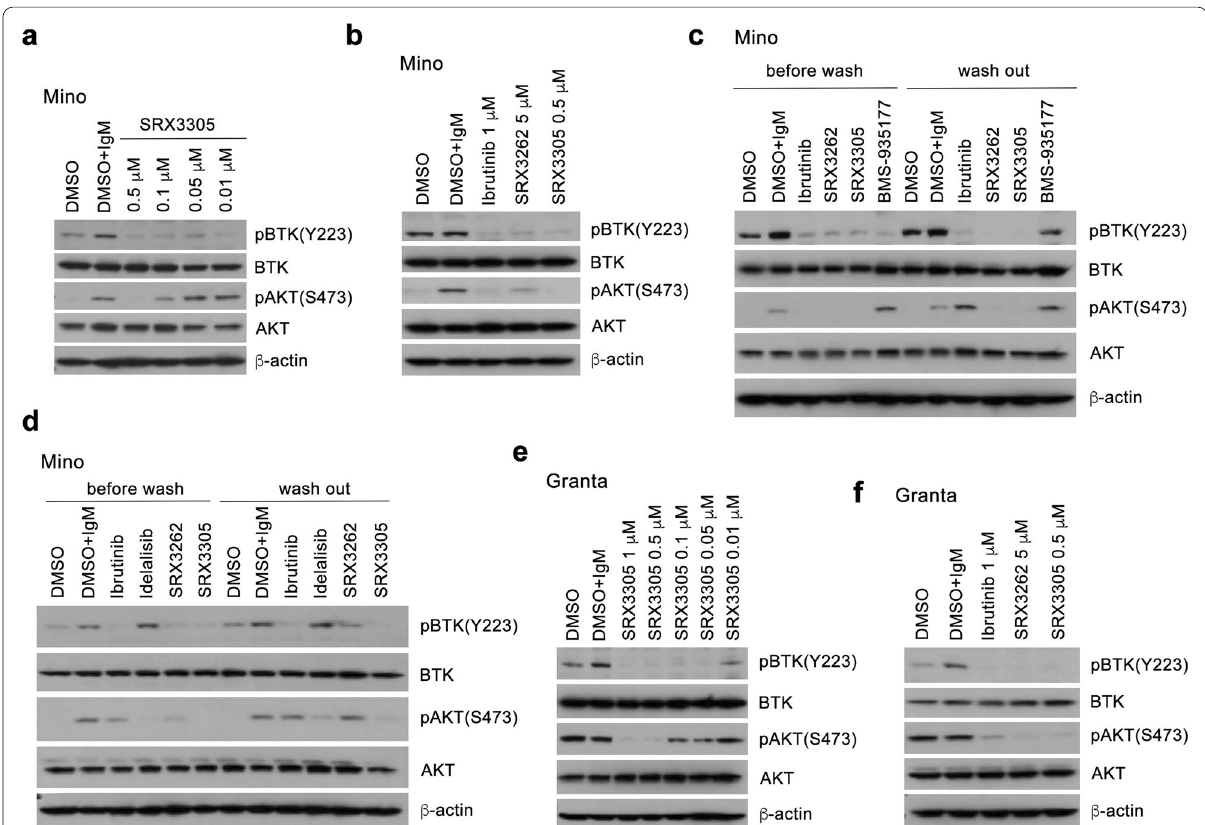
Fig. 3 SRX3305 is efficacious in MCL and Ibrutinib‑resistant MCL cells. a , b Western blot analysis of lysates from IgM‑stimulated Mino cells treated with the indicated concentrations of Ibrutinib, SRX3305 or SRX3262 for 1 h. BTK and PI3K signaling was assessed by the levels of BTK, phosphorylated at Y223 BTK [pBTK(Y223)], AKT, and phosphorylated at S473 AKT [pAKT(S473)]. c , d Western blots analysis of lysates from IgM‑stimulated Mino cells without and with washing out indicated inhibitors 24 h post treatment. e , f Western blot analysis of lysates from IgM‑stimulated Granta cells treated with increasing concentrations of SRX3305, SRX3262 or Ibrutinib for 1